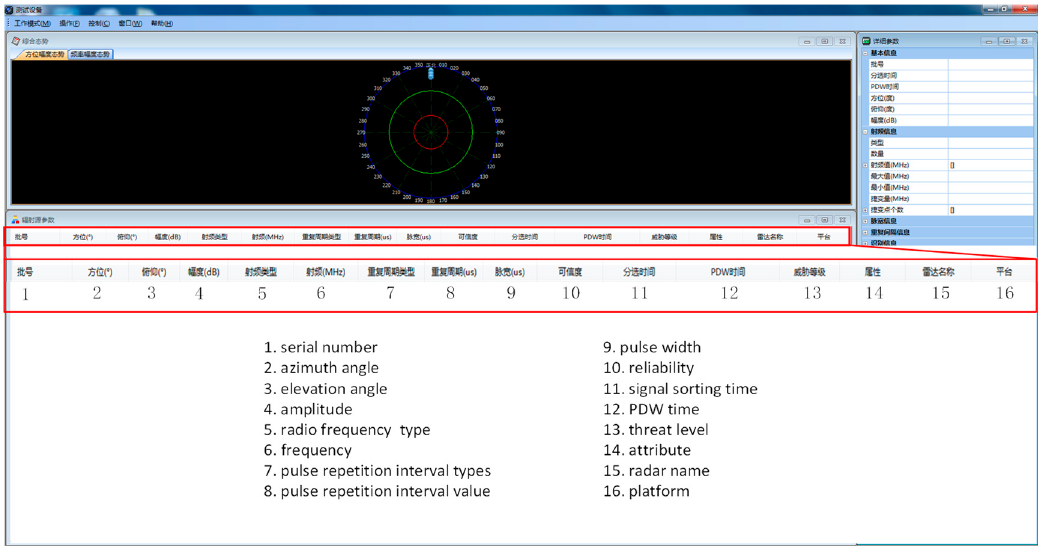
Figure 13. Display terminal interface of signal reconnaissance system.